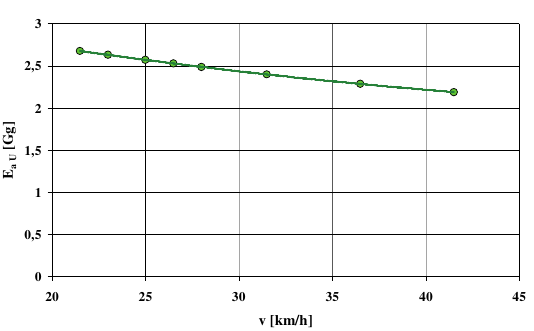
Fig. 13. Dependence of the national annual emission of particulate matter PM2.5 from tribological elements of passenger cars upon the average velocity, under model conditions of urban traffic